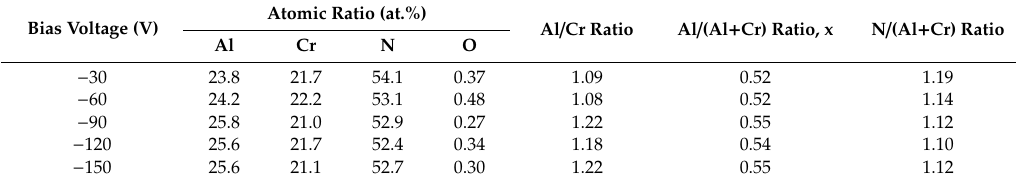
Table 4. Concentration of CrAlN coatings under various bias voltages.